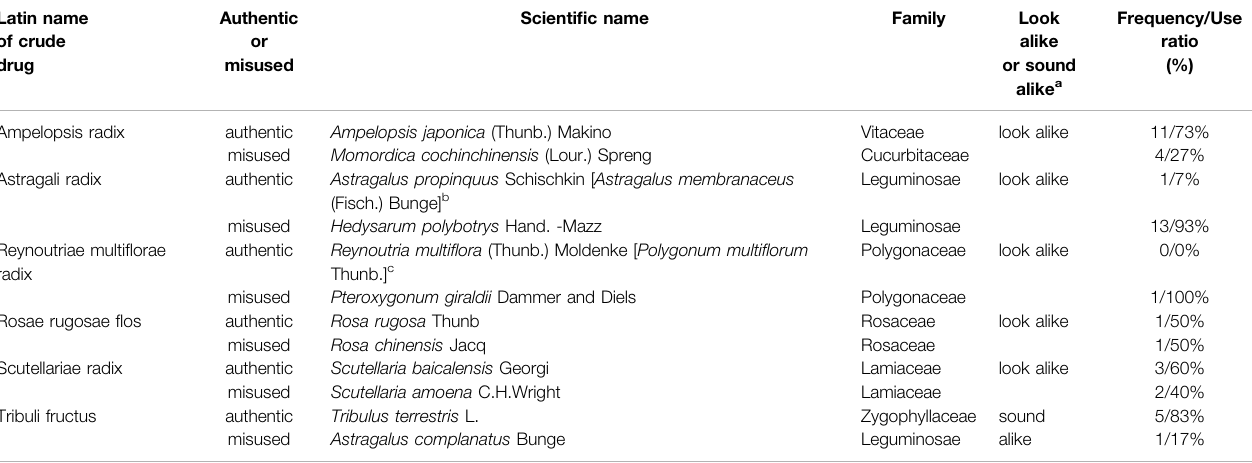
TABLE 3 | Summary of medicinal materials that tend to be misused in skin whitening prescriptions. Latin name of